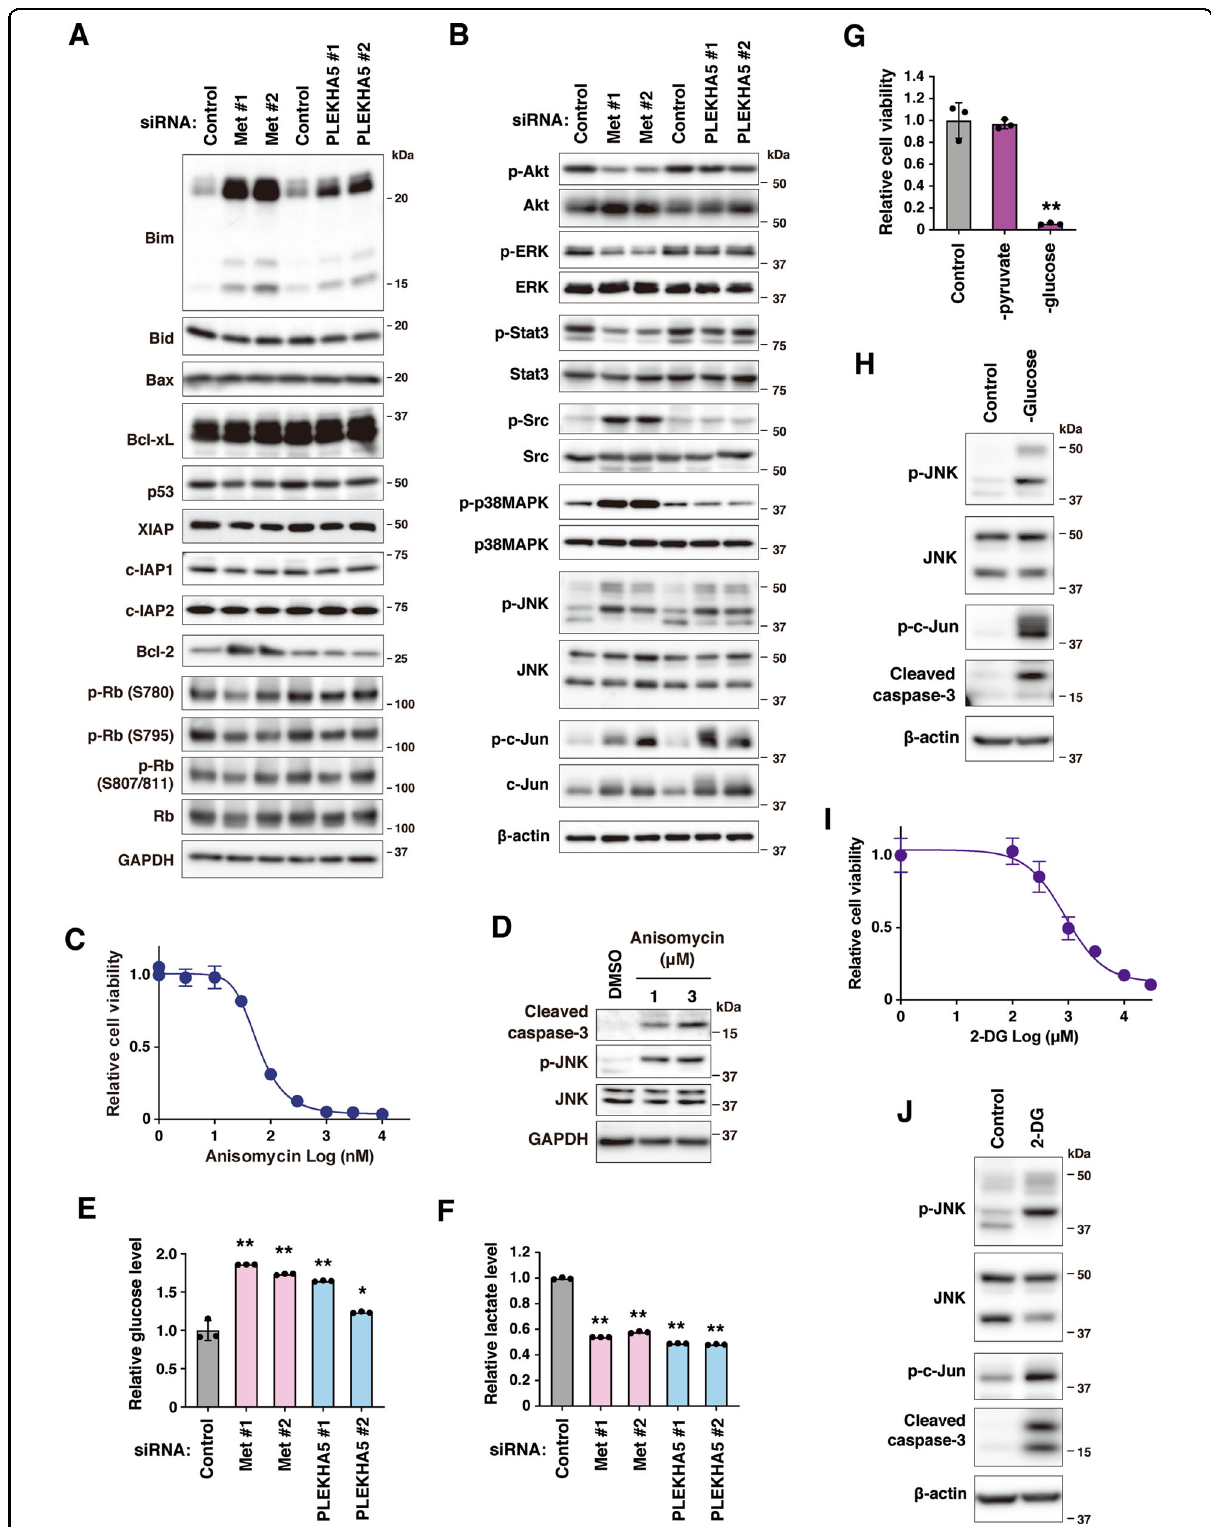
Fig. 6 (See legend on next